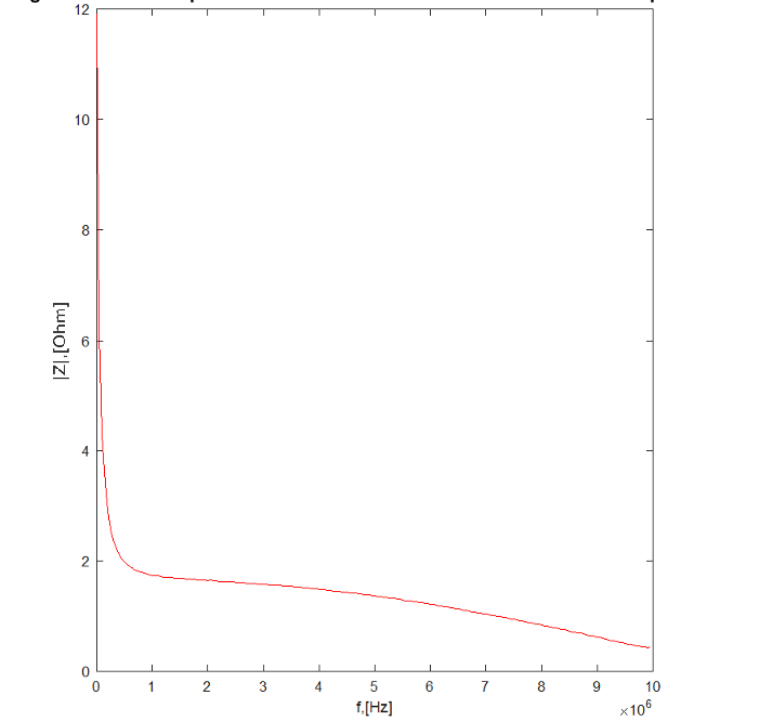
Figure 20. Linear characteristics of the impedance of the accelerometer data output terminals as a function of frequency.